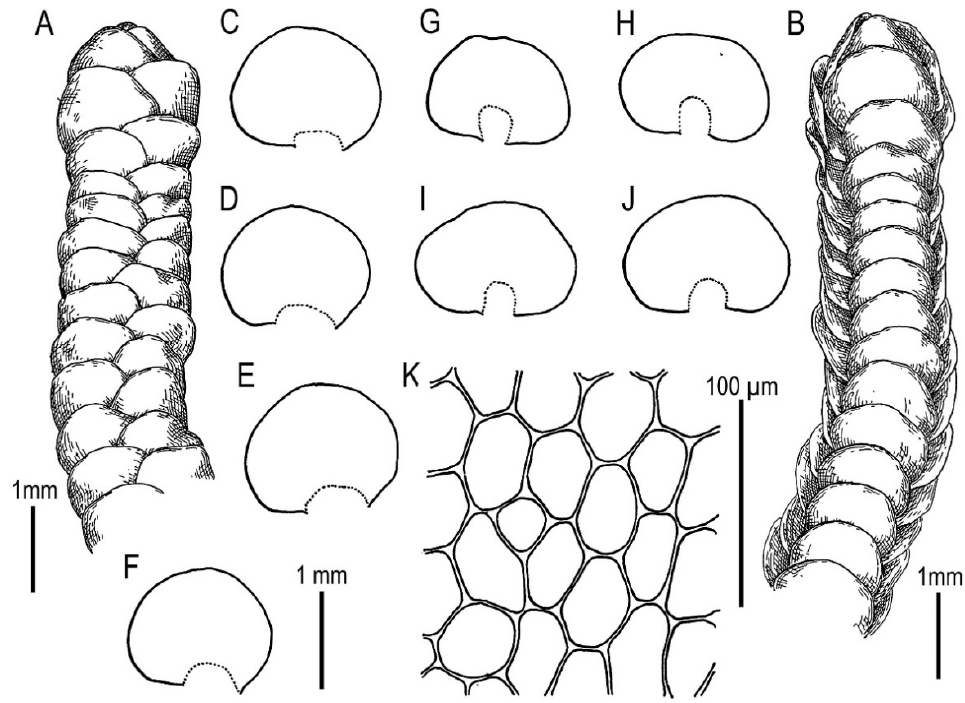
Figure 6. Calypogeia aeruginosa Mitt.: ( A ) Plant habit, fragment, dorsal view; ( B ) Plant habit, frag- ment, ventral view; ( C – F ) Leaves; ( G – J ) Underleaves; ( K ) Midleaf cells. All from V-8-36-17 (VBGI).